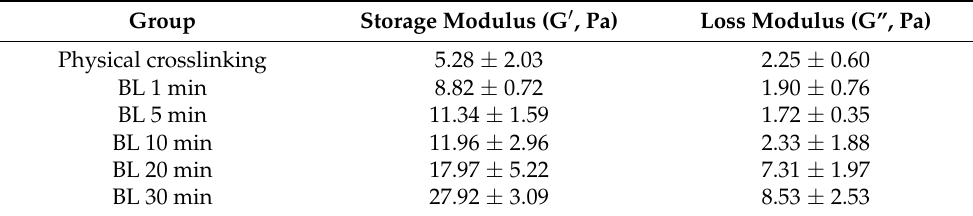
Table 1. Storage and loss moduli of physically and chemically crosslinked collagen hydrogels. Group Storage Modulus (G′, Pa) Loss Modulus (G”, Pa)